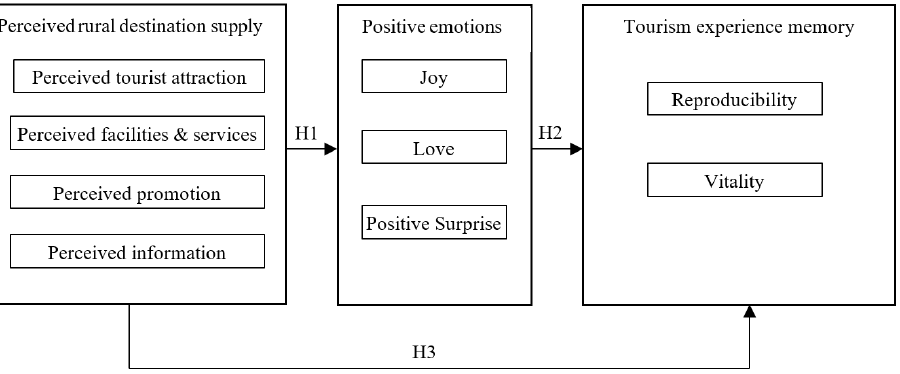
Figure 1. Theoretical model of the relationship between the antecedents of rural tourism experience memory. Hypothesis 4. Positive emotionsmediate the relationship between tourists’ perceptions of destina- tion supply and tourism experience